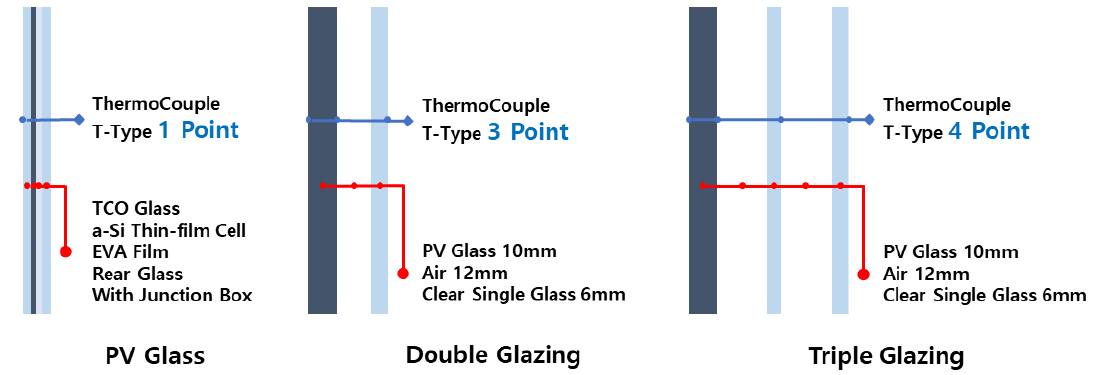
Figure 2. Sketch for each photovoltaic (PV) glazing type.